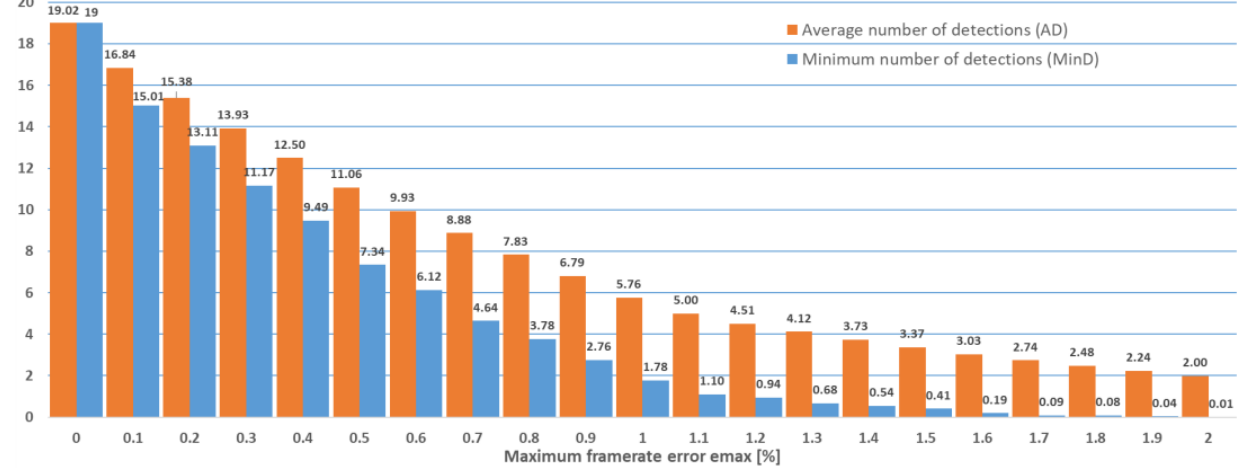
Figure 6. Minimum number of detections (MinD) and average number of detections (AD) out of a maximum of 20 (60 frames per second case). Table 2. Statistical analysis of the ADT and MaxDT (60 frames per second case).